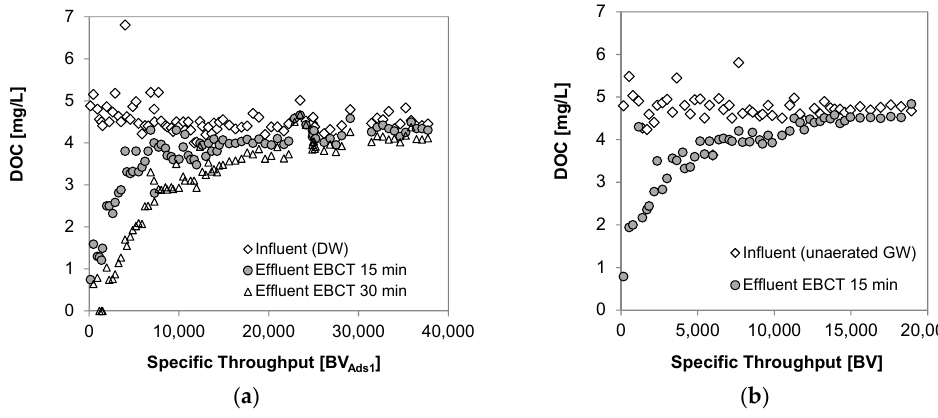
Figure 4. Concentrations of DOC in ( a ) the influent and effluents of the first and second DW-fed adsorbers vs. throughput and in ( b ) the influent and effluent of the GW-fed adsorber.